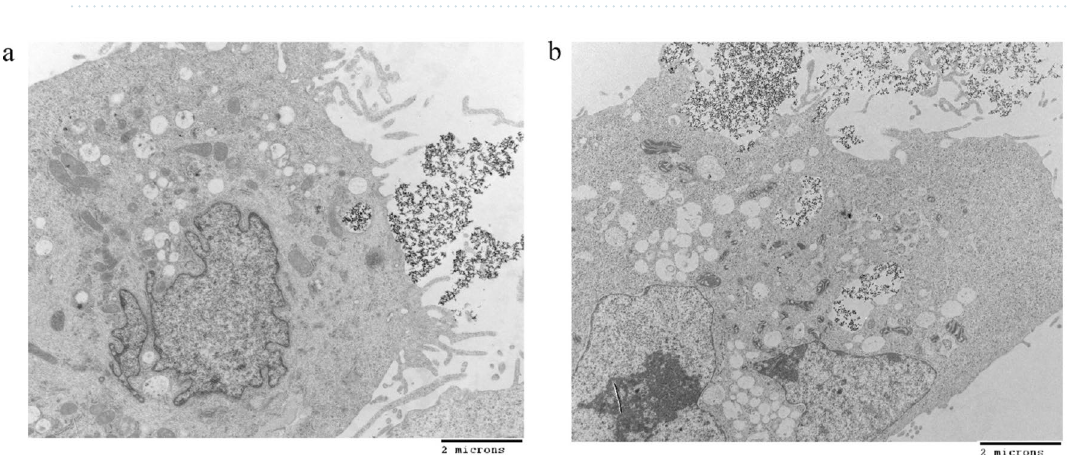
Figure 4. TEM images of nanoparticles uptake by U251 cells cell after 4 h of the treatment, ( a ) EDT-IONPs and ( b )